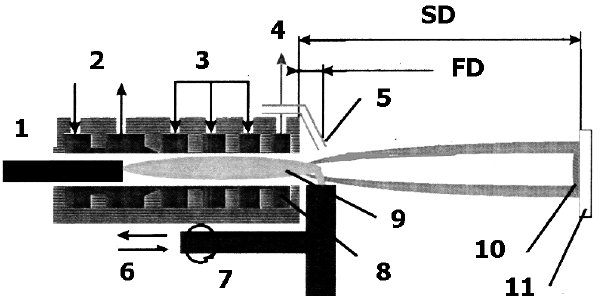
Figure 1. WSP plasma spraying. 1—cathode; 2—water in and out for cathode cooling; 3 and 4—water in and out for plasma stabilization; 5—powder feeding tube; 6—water in and out for anode cooling; 7—anode rotation; 8—water vortex; 9—electric arc; 10—coating; 11—substrate; SD—spray distance; FD—feeding distance.